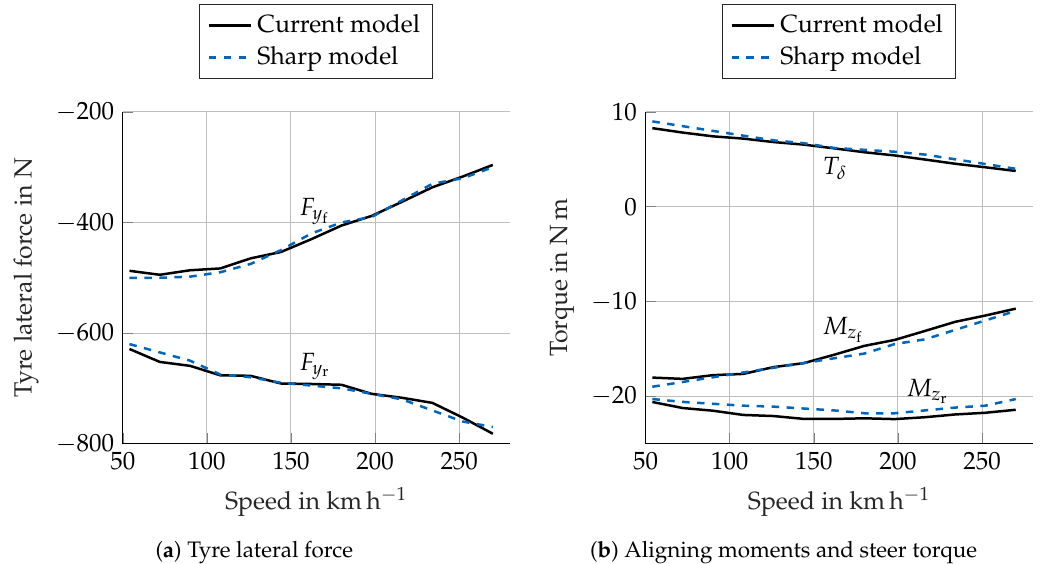
Figure 2. Model validation with steady-state analysis: comparison between the current model and the model of Sharp for a steady-state cornering maneuver. F y , M z are the front and rear tyre aligning moments and T δ is the steer while M z r f